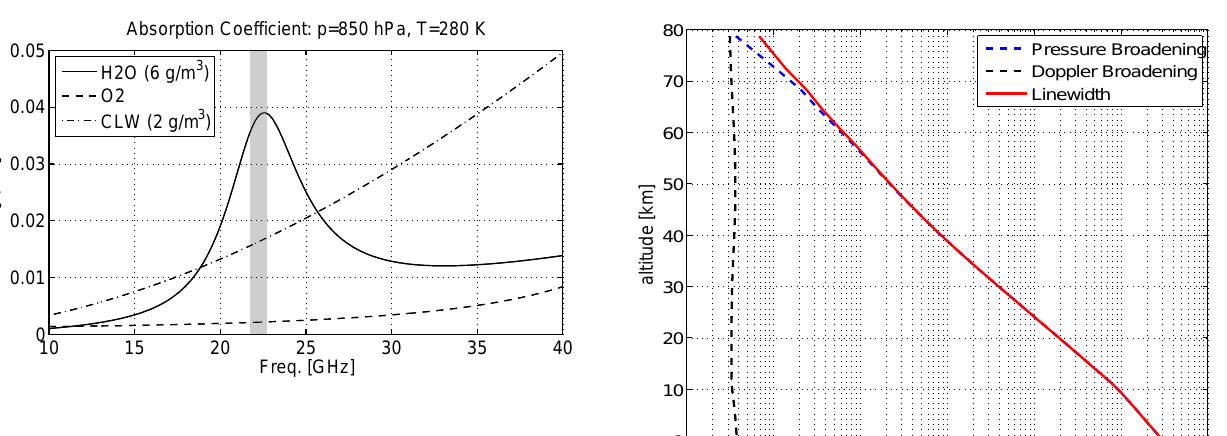
Fig. 1. Simulated absorption coefficients between 10 and 40GHz at 850hPa for water vapour and further major contributors in this frequency range, which are oxygen (mainly the wing of the strong 60GHz-line) and cloud liquid water (CLW). The shaded area marks the bandwidth of the MIAWARA-radiometer (from Haefele and K¨ampfer, 2009).